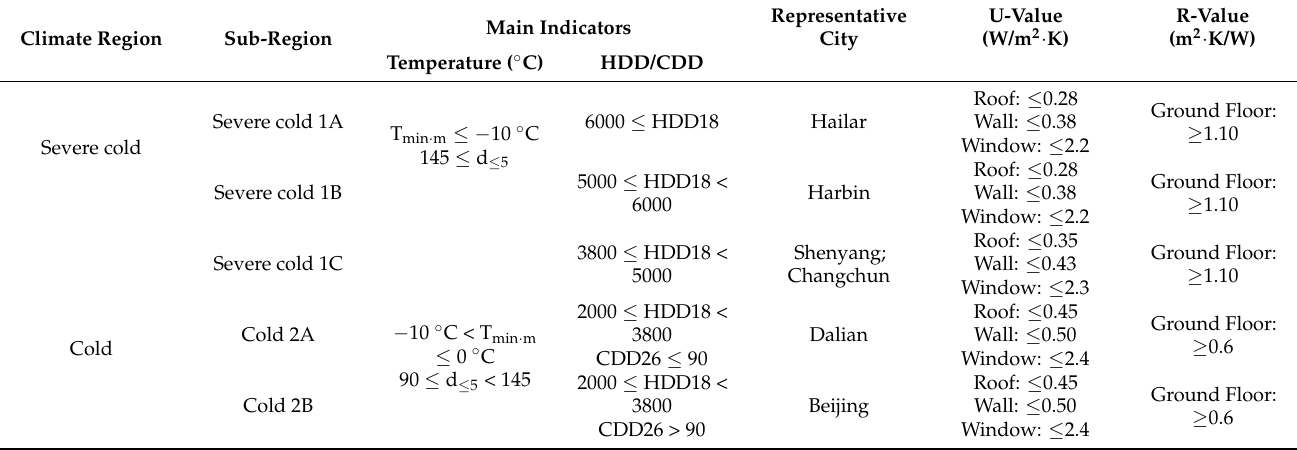
Table 3. Case study parameters for severe cold and cold climate regions in China. Climate